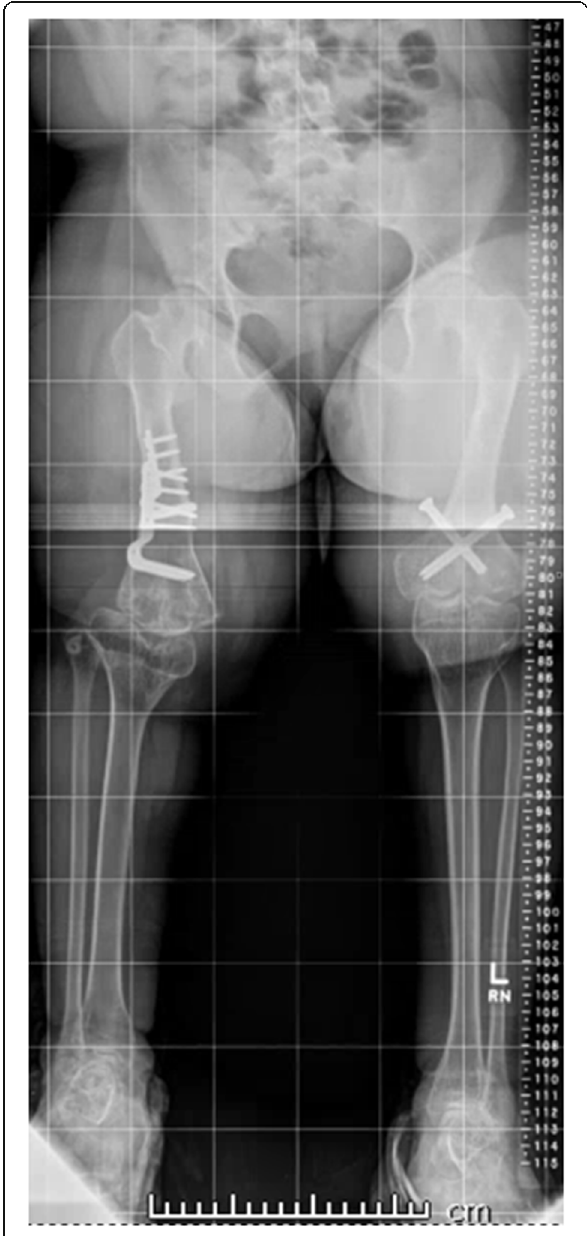
Fig. 4 Lower extremity alignment films, at age 13 years 10